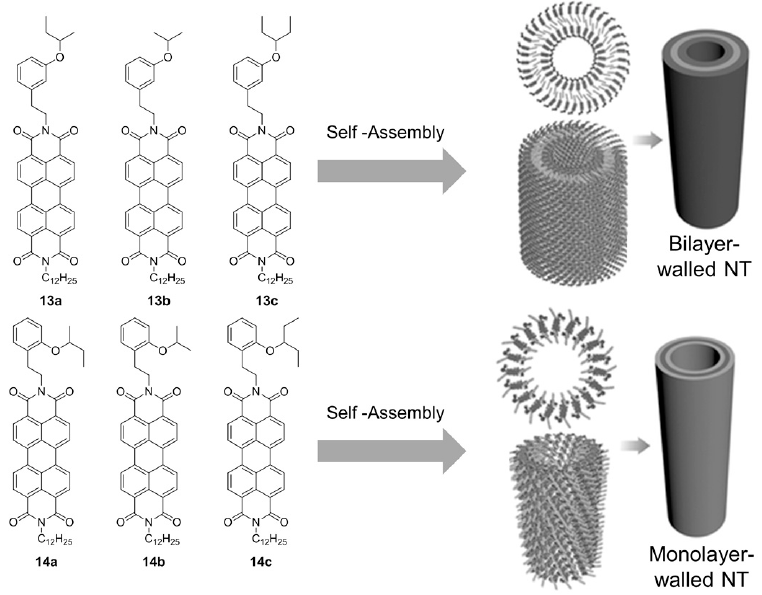
Figure 11. PDI-based building blocks for construction of chiral NTs. Partially reproduced with permission from Ref. [52] (Copyright Wiley-VCH, 2016).